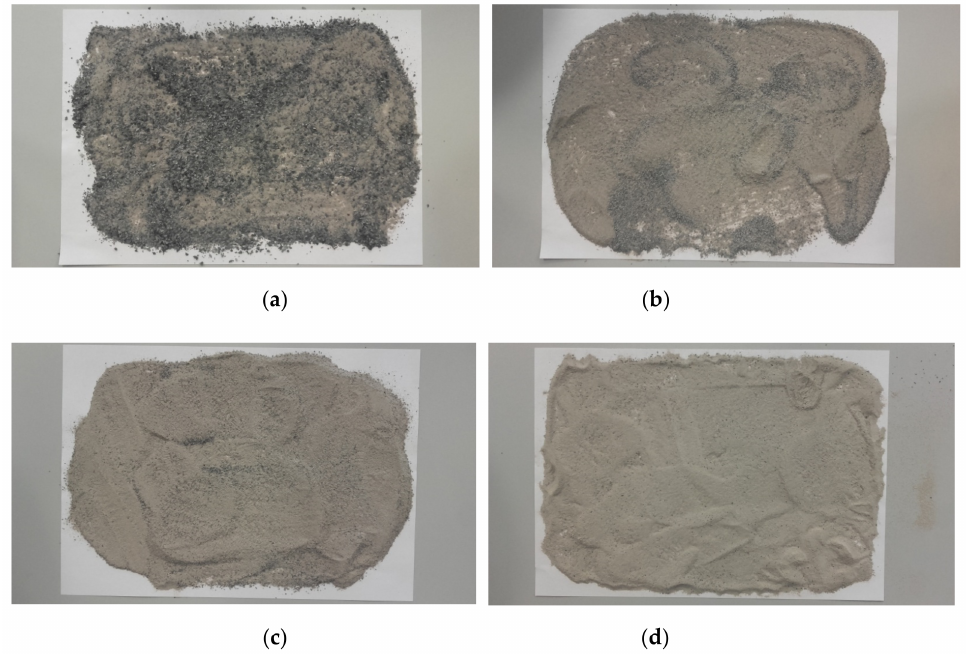
Figure 4. A view of RCA–RTW mixtures. ( a ) M5_RCA_20R_0FF; ( b )